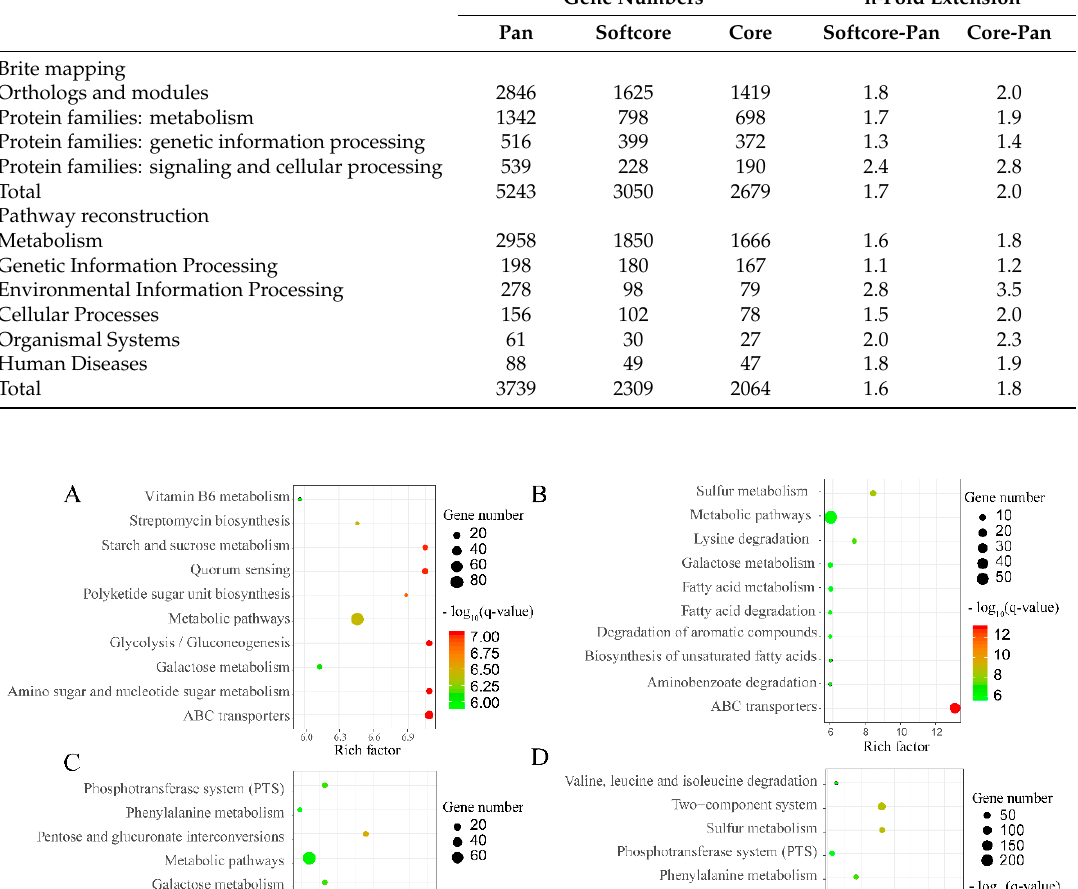
Table 2. Reconstruction of pan-, core, and softcore genome of all the genomes with Brite and Pathway algorithm of GhostKOALA. Brite mapping Orthologs and modules